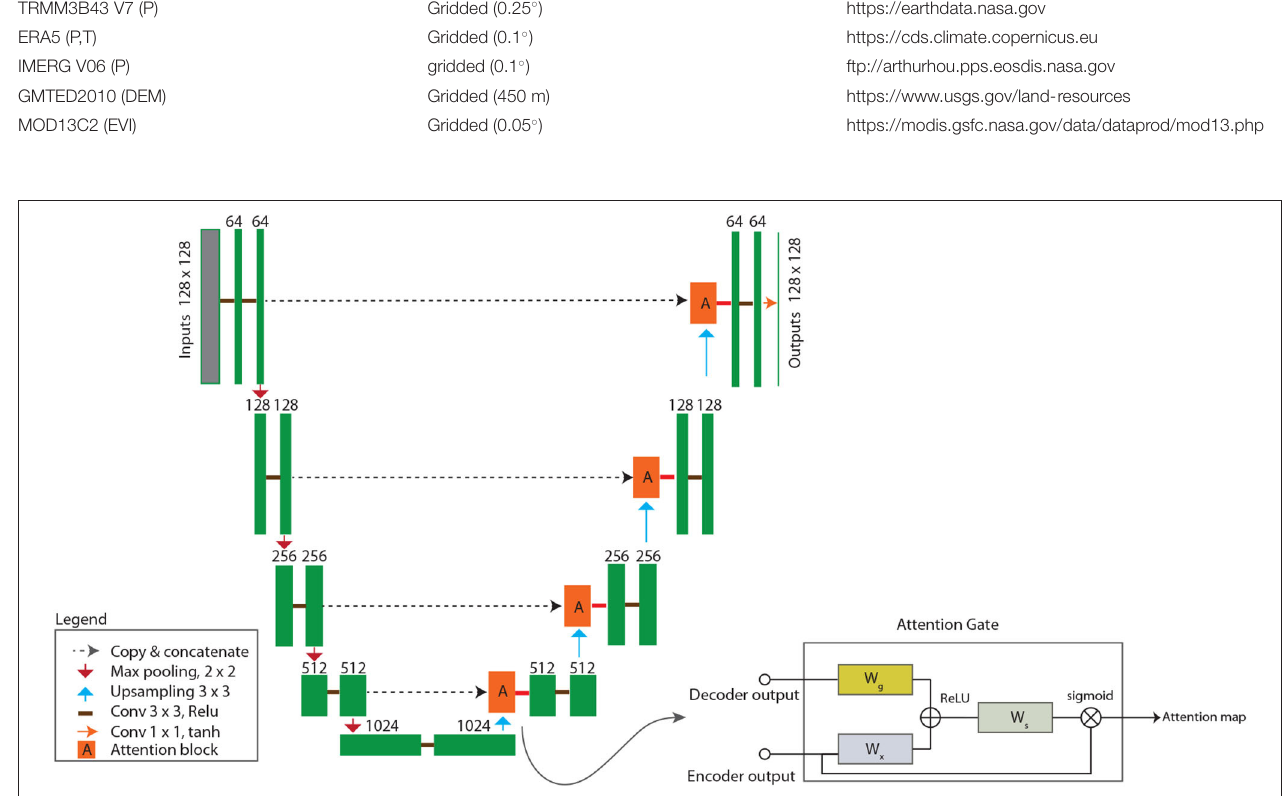
FIGURE 2 | Model architecture of attention-based U-Net (AU-Net), which consists of a pair of encoder and decoder for end-to-end learning. Green blocks are convolutional blocks, for which the number of kernels used is labeled on top of each block. Red blocks are attention gate blocks, the design of which is shown in the callout on bottom right. Dashed arrow lines are skip connections. Most hidden convolutional layers use 3 × 3 kernels and the ReLU activation function, except in the attention block and in the output layer, where 1 × 1 kernels and tanh are used. Meanings of other symbols are explained in the legend shown at bottom left.